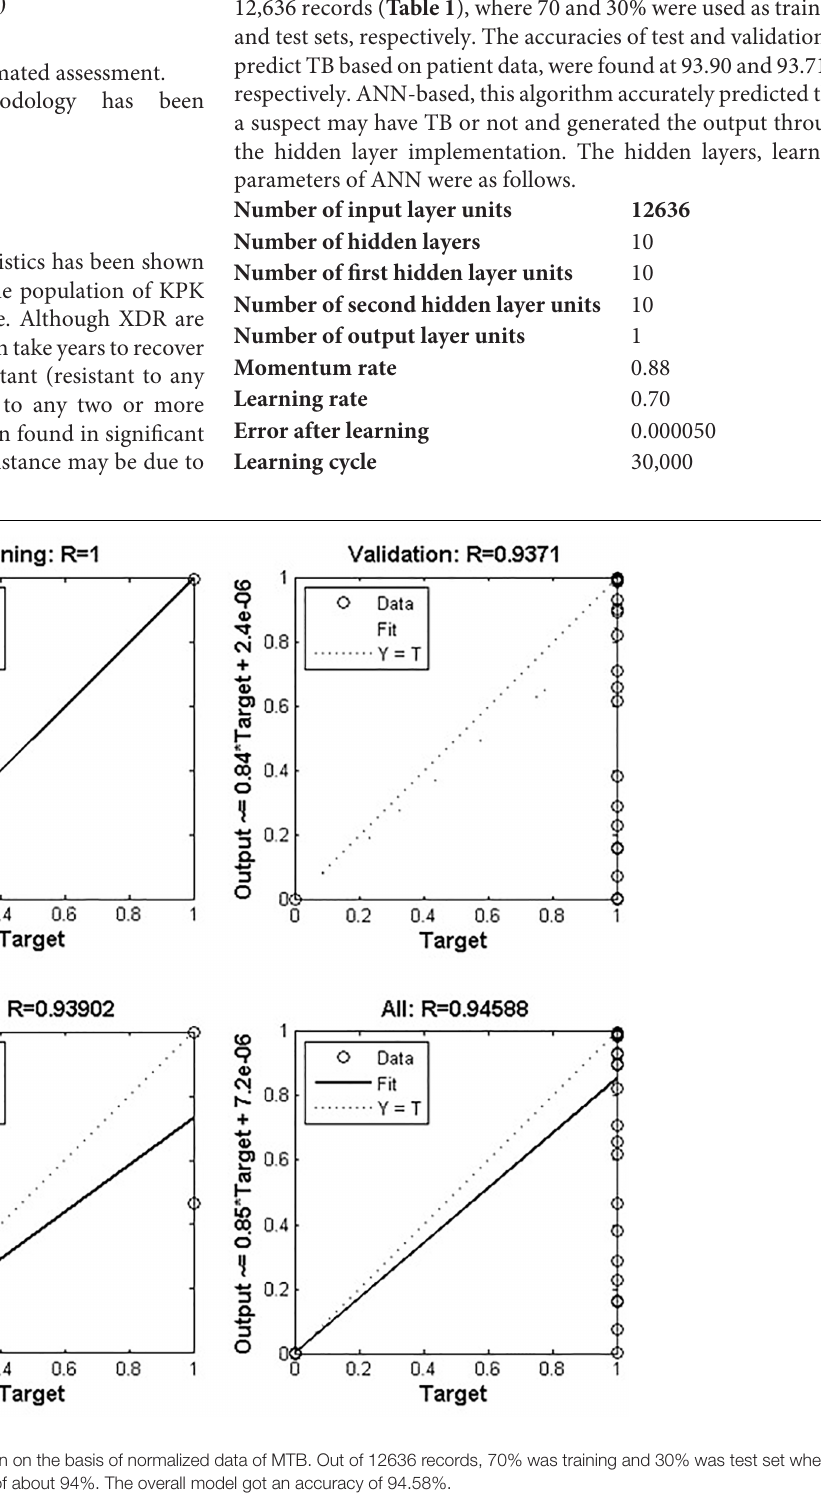
Frontiers in Microbiology |